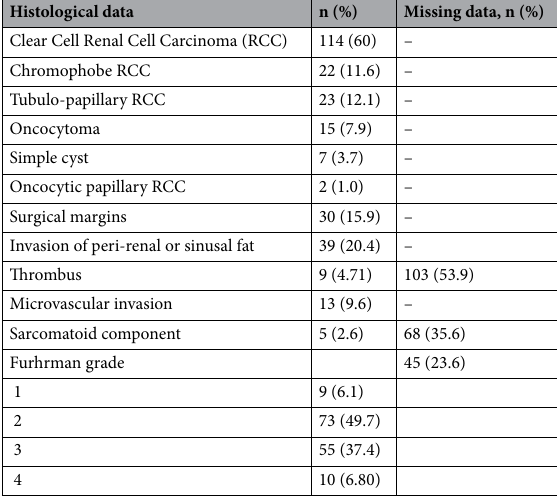
Table 2. Histological data of tumors.